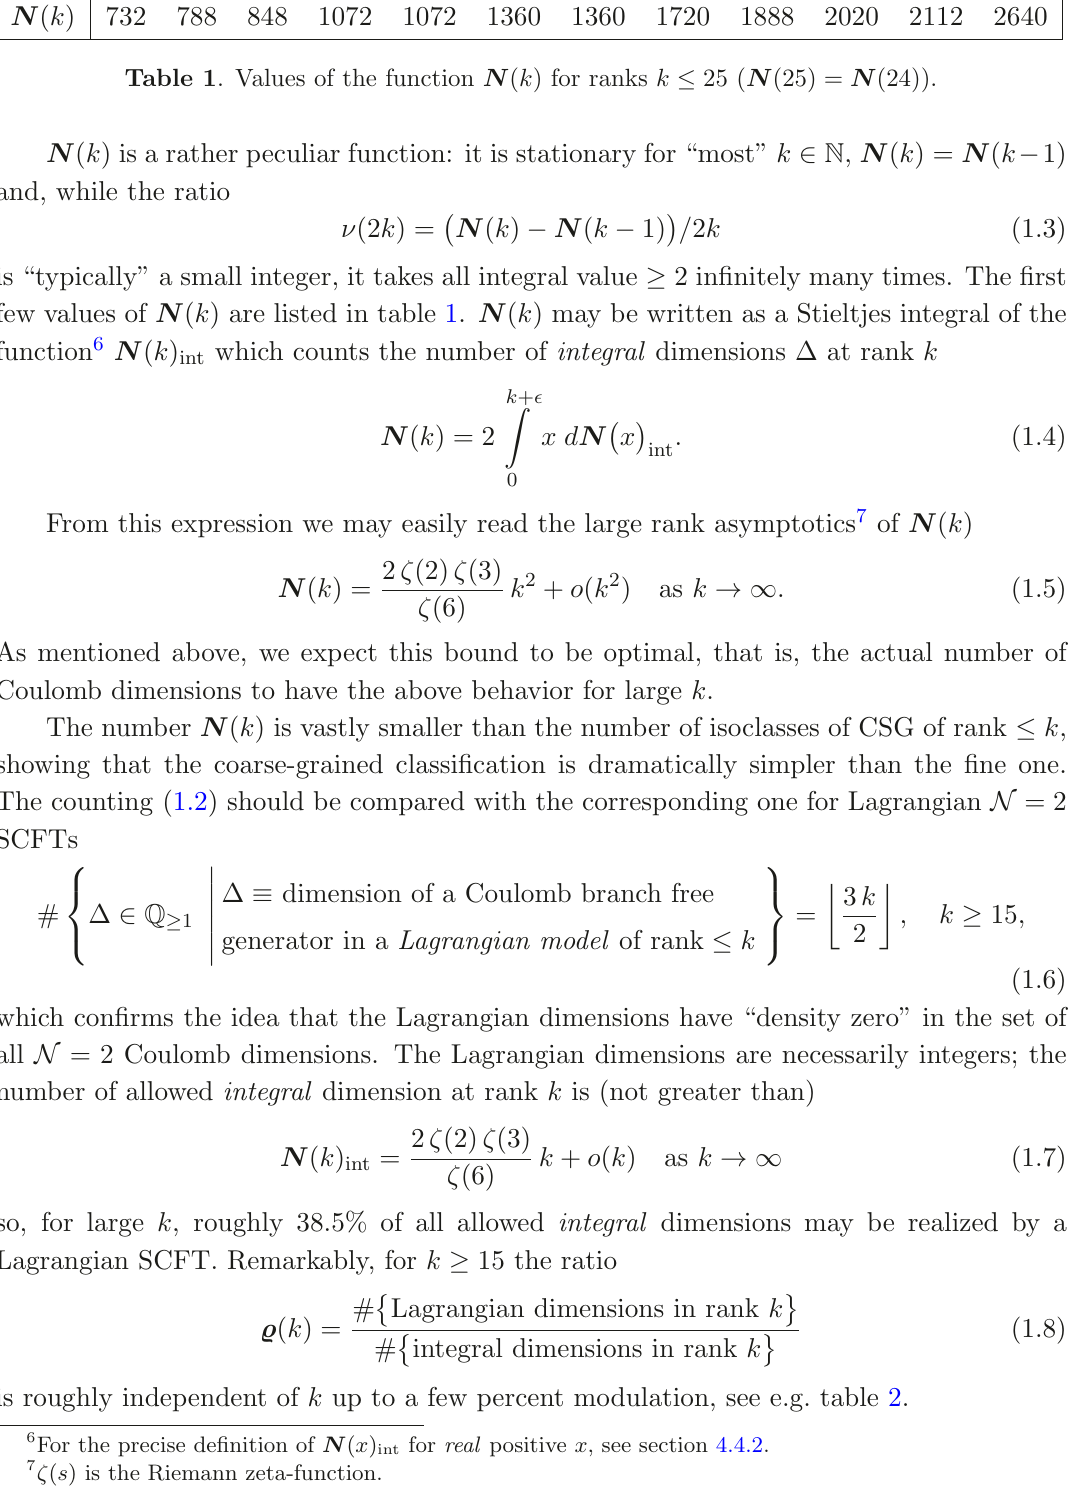
Table 1 . Values of the function N ( k ) for ranks k